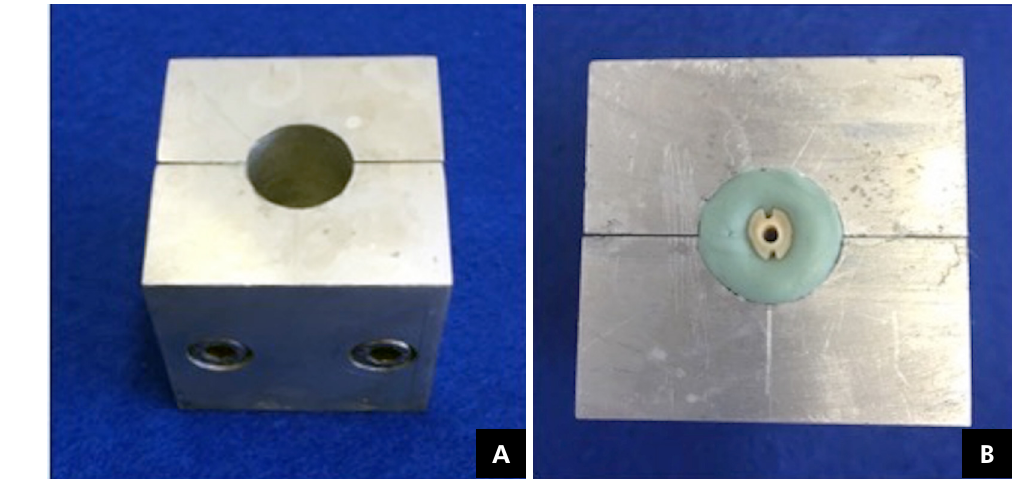
Figure 1. (A) Two-piece metal muffle used to make the silicone mould. (B) Sample inserted in the silicone mould to allow the two halves to reassemble before and after the irrigant